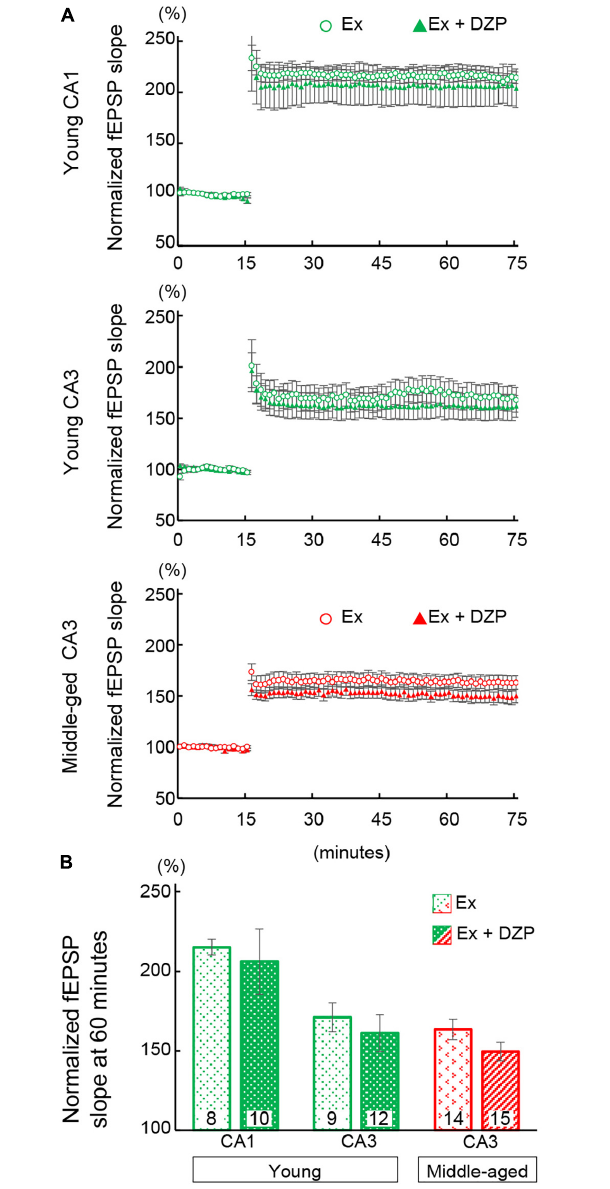
FIGURE 5 | Effects of exercise on hippocampal long-term potentiation in chronic diazepam- or vehicle-administered young and middle-aged mice. (A) Averages of every 1 min of normalized fEPSP slopes were plotted. Theta burst stimulation was delivered at 15 min of recording to induce long-term potentiation. (B) To compare the magnitudes of long-term potentiation, the normalized fEPSP slopes of 60- to 75-min recordings were averaged and are summarized as a bar graph. The number in bar graph indicate the number of recorded slices ( N = 5 animal, 1–3 slices/animal). Error bar: mean ± SEM.